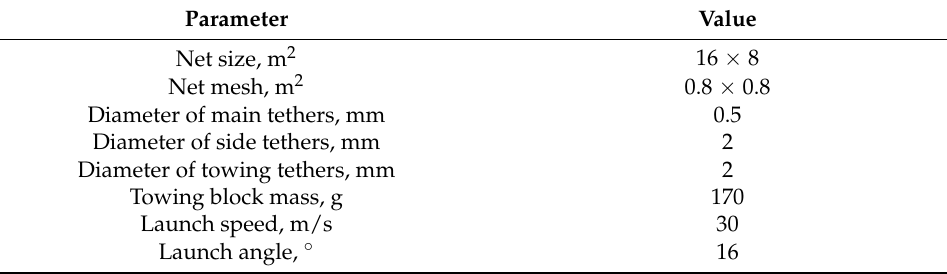
Table 1. Initial parameters of the dynamic model.